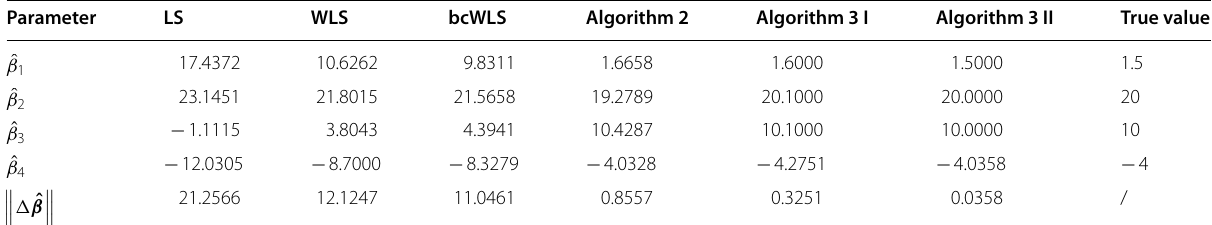
Table 8 Parameter estimates and the 2-norm results between the parameter estimates and true values in the case of σ m = 0.05 for the third